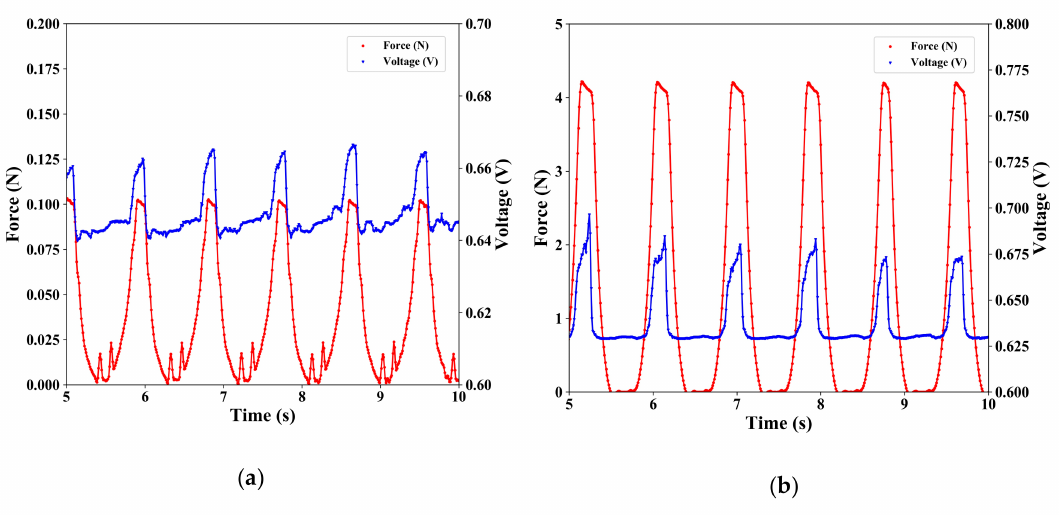
Figure 9. Response for pulsed input with a pushing depth of 0.5 mm: ( a ) soft-MPS (soft); ( b ) soft-MPS (hard).